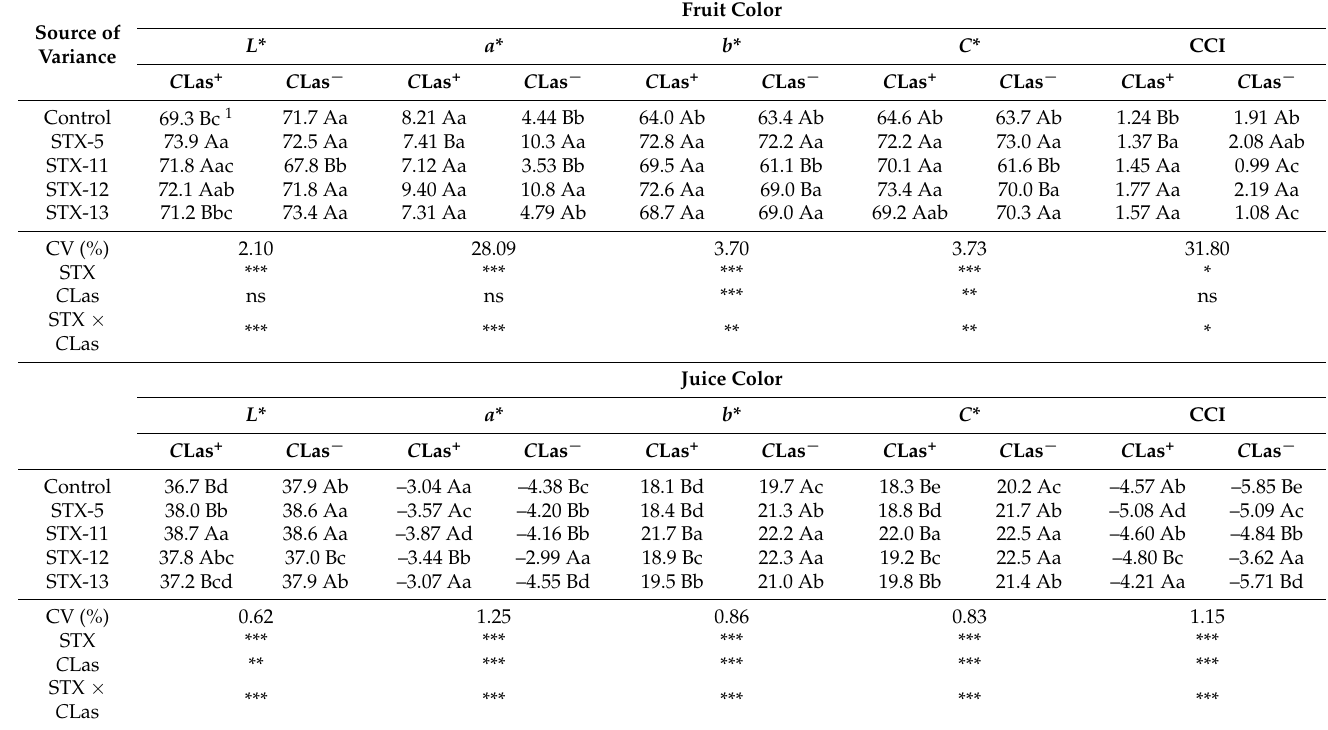
Table 2. Fruit and juice color attributes, including lightness ( L *), red/greenness ( a *), yellow/blueness ( b *), chroma ( C *), and citrus color index (CCI), of ‘ Candidatus Liberibacter asiaticus’ ( C Las + )-inoculated and non-inoculated (CLas − ) STX IA transgenic and non-transgenic control plants of Pera sweet orange ( Citrus × sinensis